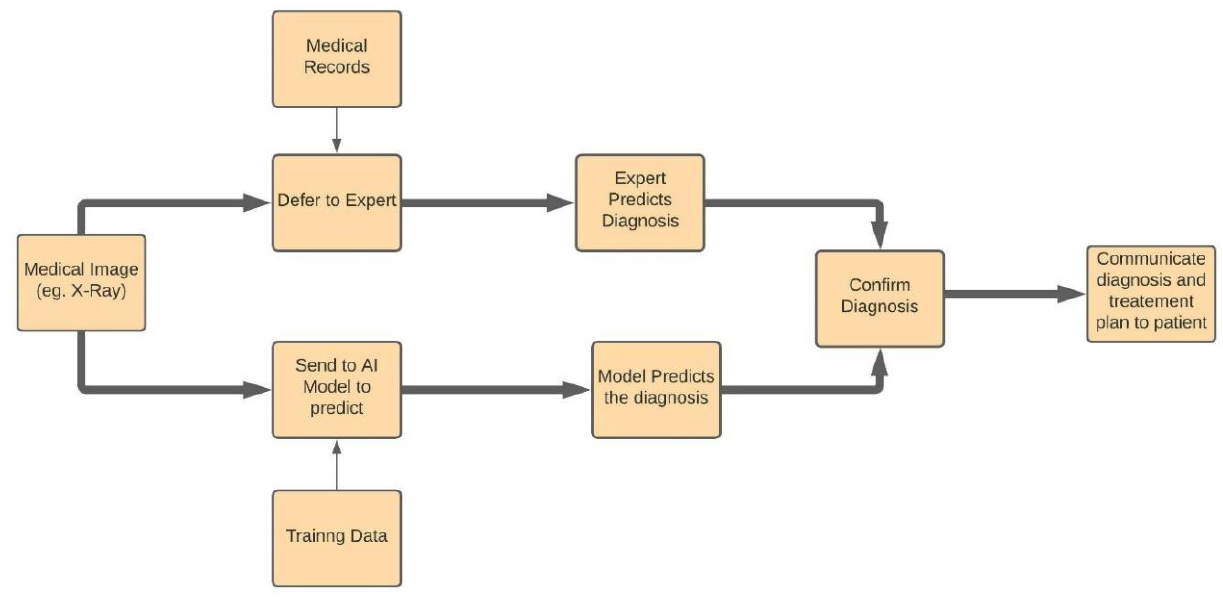
Figure 5. The Process Flow Representation of Medical Image Diagnosis using AI.